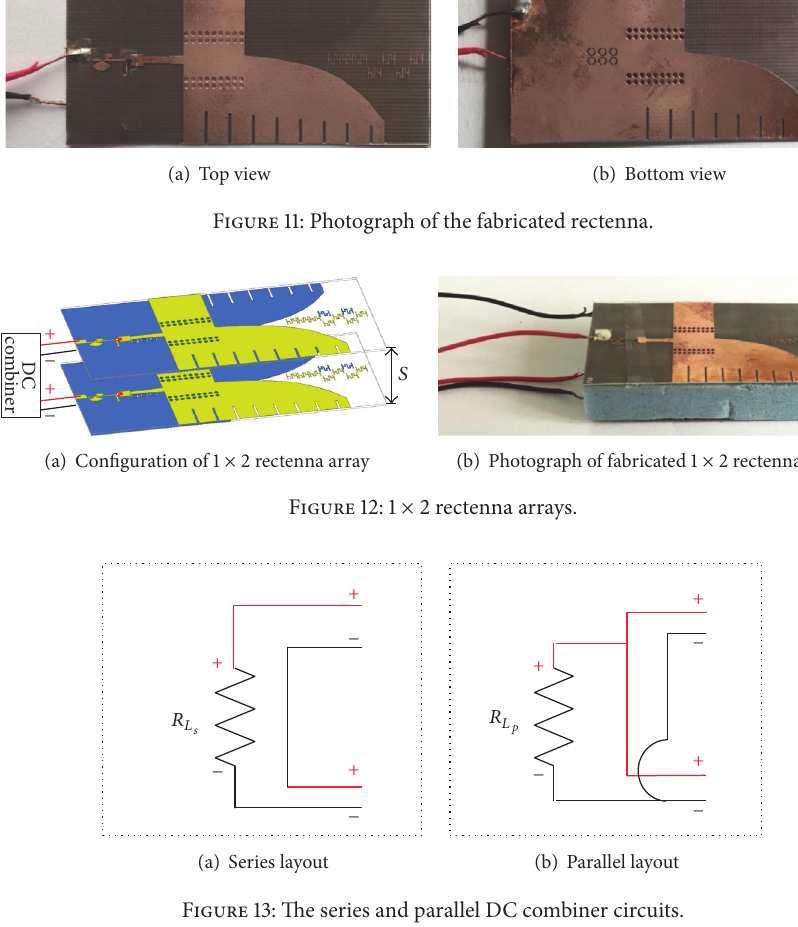
Figure 13: The series and parallel DC combiner